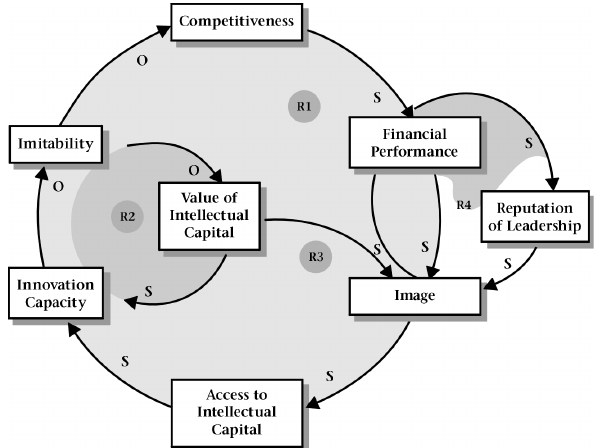
Figure 5: The Business Case for Intellectual